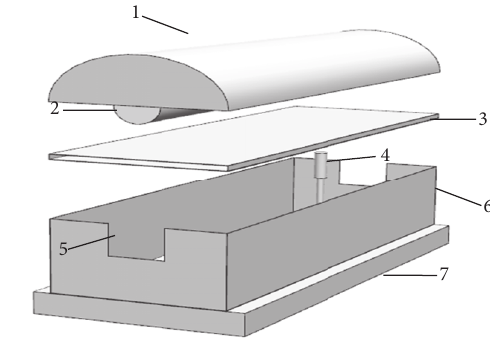
Figure 1: Reactors: 1: ultraviolet collector, 2: UV light source, 3: glass slide, which was loaded with catalyst, 4: sampling mouth, 5: the overflow mouth, 6: the reaction zone, and 7: